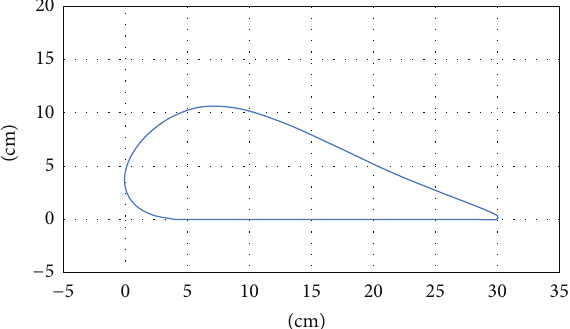
Figure 5: Trajectory of the footpad in walking on a flat surface.